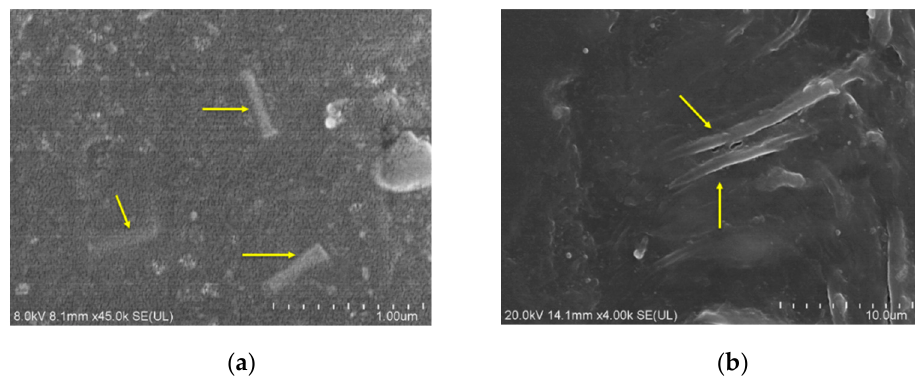
Figure 3. SEM micrographs of Al 2 O 3 /LDPE composites ( a ) randomly dispersed, ( b ) array dis- persed.